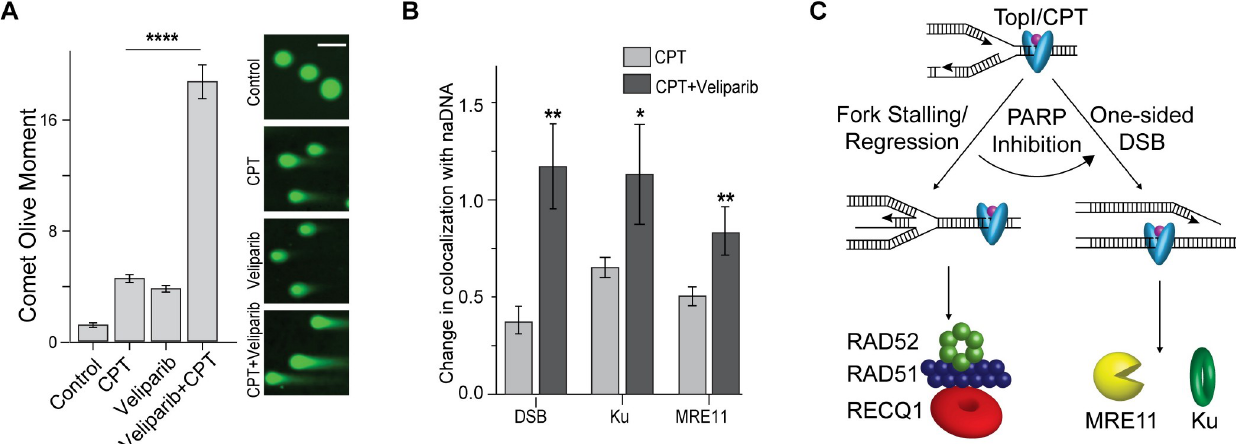
Fig 5. PARP inhibition converts RAD52/RAD51 protected RFs into seDSBs. (A) Comet assays of cells damaged with CPT, Veliparib or both demonstrating synergistic DSB induction upon TopI-induced RF stress combined with PARP inhibition. Representative cells shown. (B) Quantification of DSB (TUNEL), Ku and MRE11 association with naDNA upon PARP inhibition using a combined Veliparib/CPT treatment. (C) A model of the two predominant stress pathways induced by TopsIcc: RF stalling/regression, which is protected and repaired quickly and colocalizes with RAD51 and RAD52, and osDSBs, which colocalize with Ku and MRE11 and are repaired via HR. Representative comet assayed cells shown, scale bars represent 15 μ m. Complete N values available in S1 and S2 Tables, number of replicates > 3, number of cells imaged typically 20–60, number of individual foci manually scored typically 50–70. All graphs show mean ± s.e.m. Student’s t-test results shown for comparison with control levels in (A) and with CPT-only (B): ns depicts p > 0.05, � depicts p < 0.05, �� depicts p < 0.01, ���� depicts p < 0.0001.